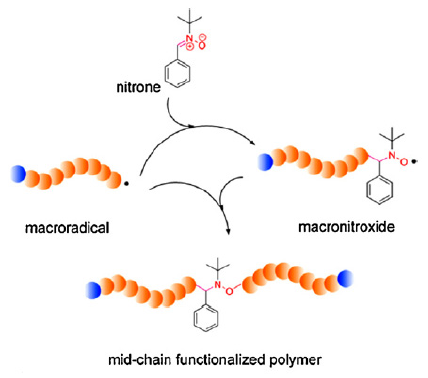
Figure 3 . Scheme of electron spin capture polymerization (ESCP). Reprinted with the permission of Royal Society of Chemistry (RSC) from ref. [43].